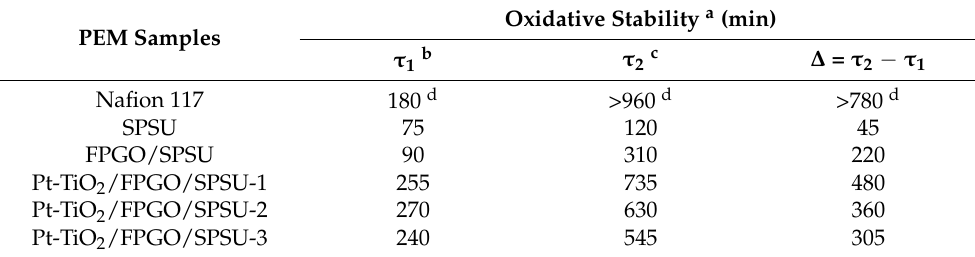
Figure 6. Photograph of all membranes immersed in Fenton reagent for 210 min at 80 °C.